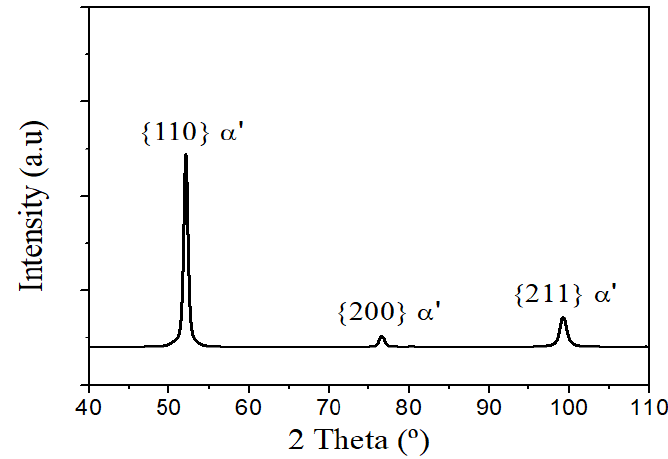
Figure 1. X-ray diffraction (XRD) spectrum of the maraging 300 alloy after solution annealing treatment at 840 °C showing α ’—peaks.